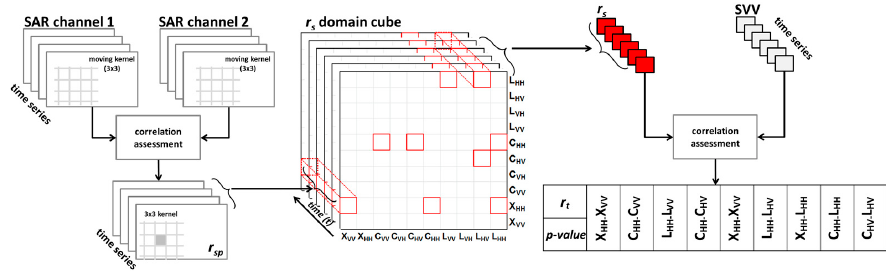
Figure 4. Flow-chart of the inter-channel spatial/temporal correlation analysis. The flow-chart is applied to each plot and for all four SVV ( m v , h’ , LAI and F v ). The 9 selected channel pairs are bounded in red within the r s domain cube.